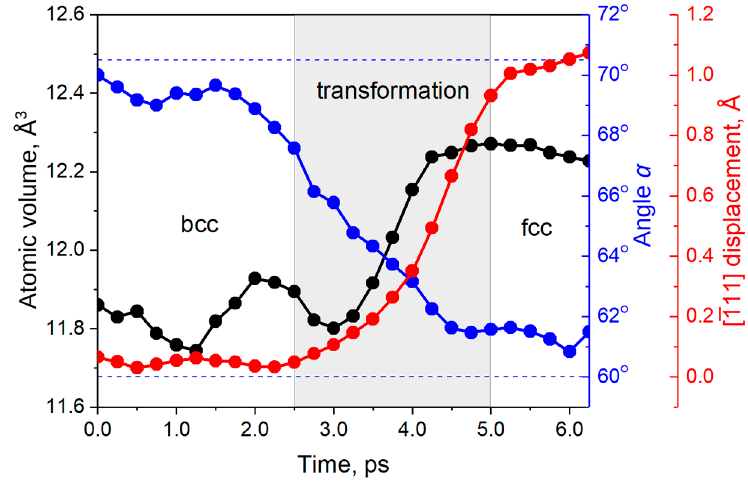
Figure 17. Time dependences of the Voronoi cell volume, angle α between adjacent <111> directions in the bcc {110} planes, and relative displacement of two adjacent bcc (110) planes in the [111] direction for atom A. The time axis originates at the strain 4.10%.